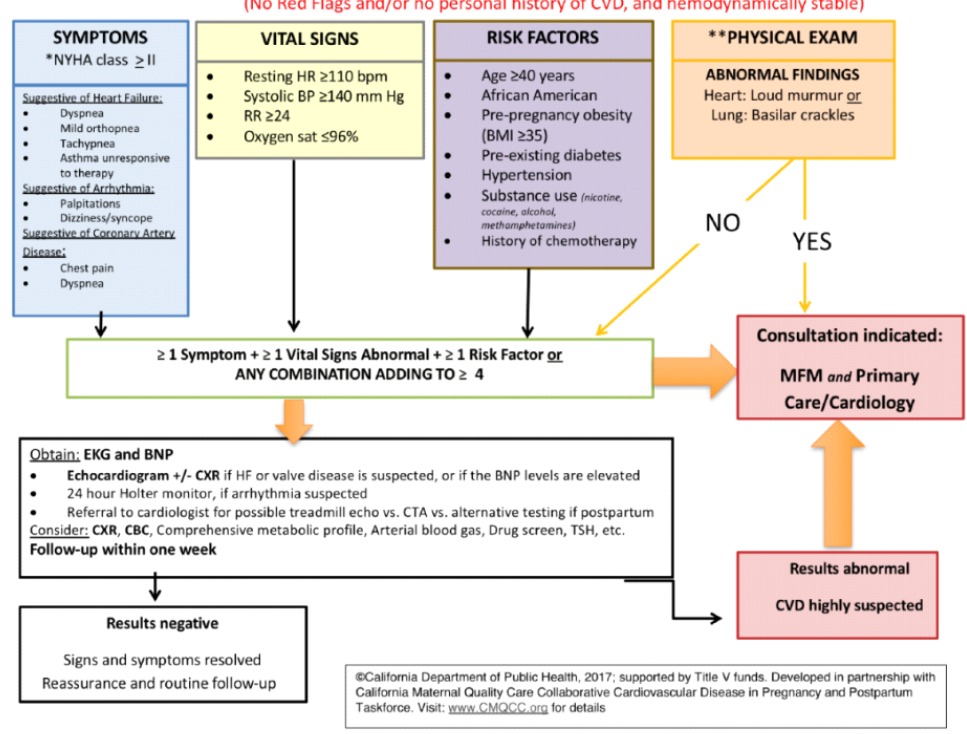
Figure 4. California Maternal Quality Care Collaborative (CMQCC) algorithm to identify pregnant and postpartum patients without red flags or personal history of CVD who are at high or low risk of CVD. * New York Hospital Association Functional Classification. ** Physical exam limited to heart (diastolic or systolic murmur) and lung (crackles, jugular venous distension, cyanosis, clubbing) exam. CVD Toolkit Application and Future